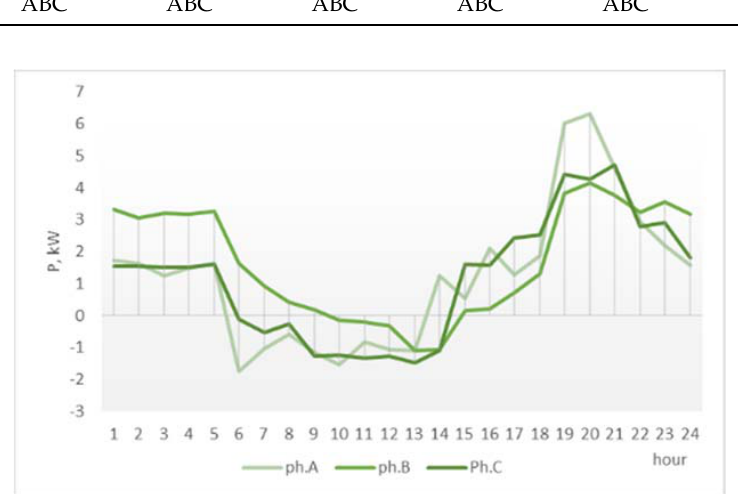
Figure 17. Actual bus demand in network R121 (aggregated demand and generation)—one-phase PSM.